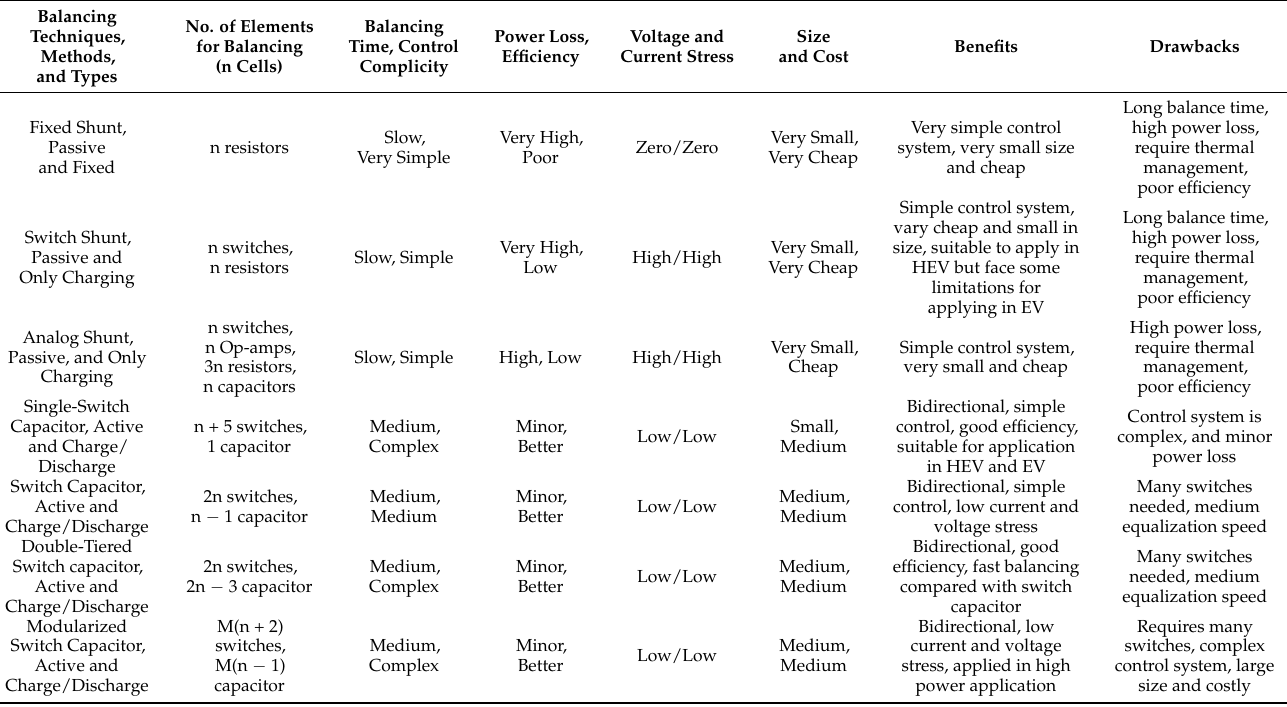
Table 1. Comparison of the charge balancing topologies